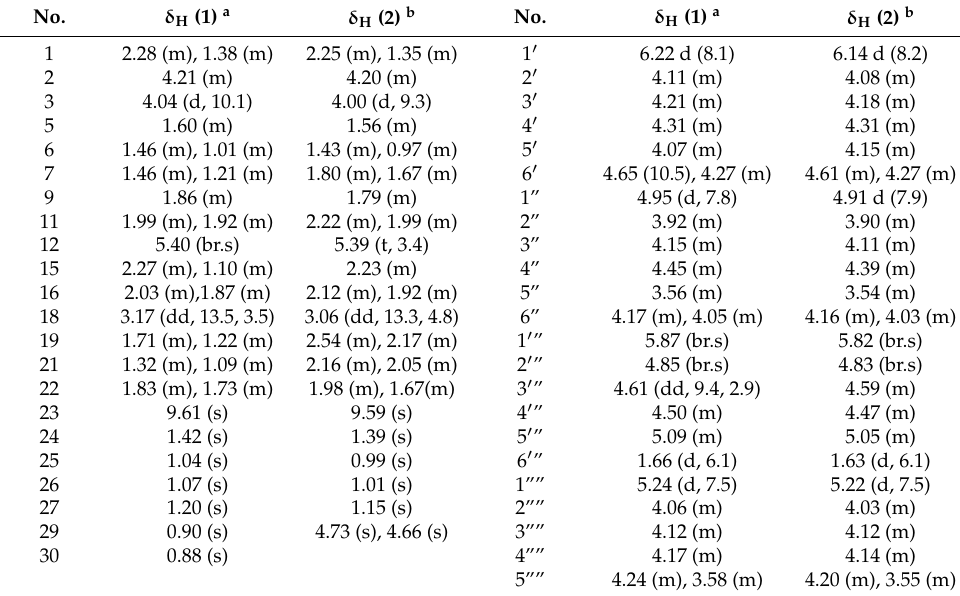
Table 1. The 1 H-NMR (500 MHz) spectral data ((ppm), J in Hz) of 1 and 2 . No.